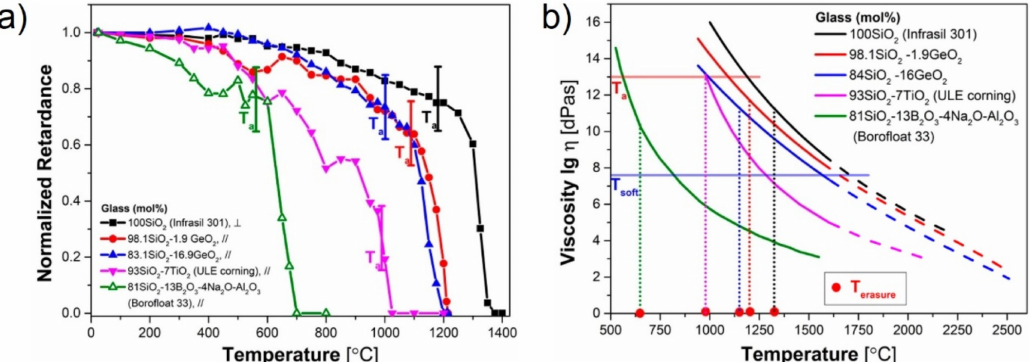
Figure 18. Influence of doping on ( a ) the glass stability, as deduced by measuring the retardance of nanogratings, and ( b ) the glass viscosity with temperature (reproduced from [66]).